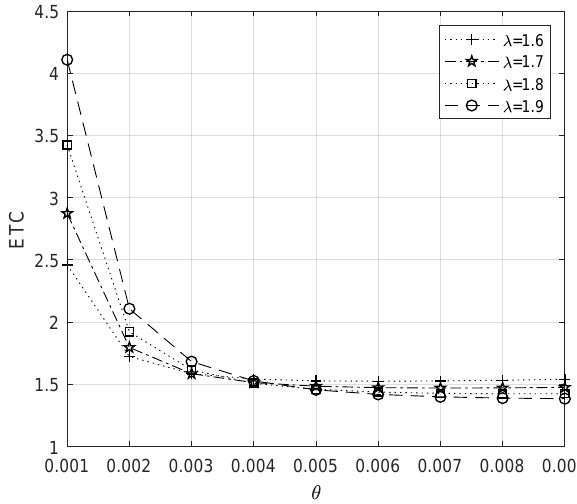
Figure 2. The impact of ETC when λ vs θ for SAM.